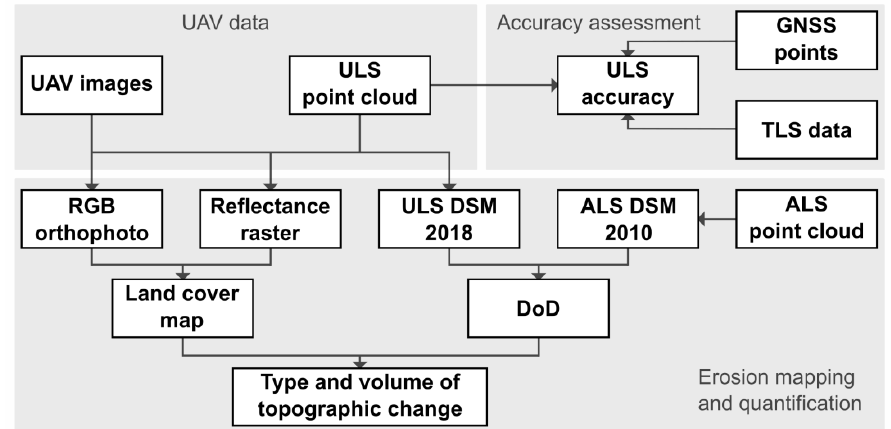
Figure 2. Schematic overview of the study